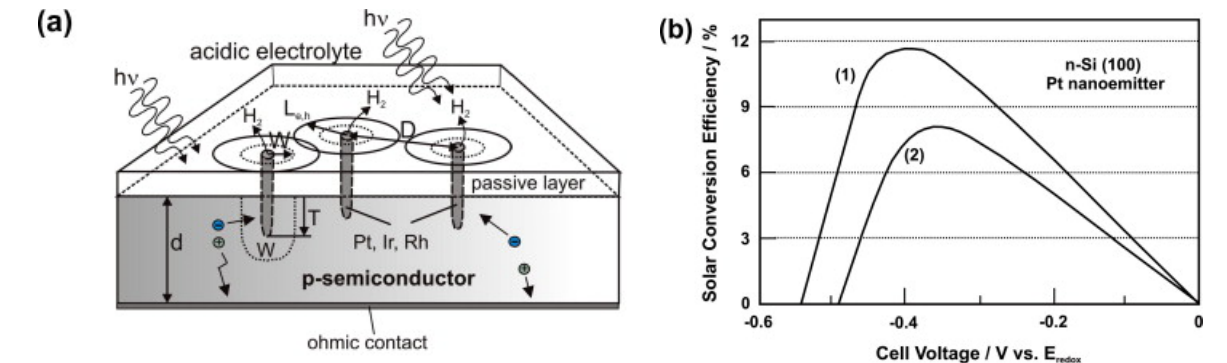
Figure 12. ( a ) Electrochemical solar cell design for protruding emitter noble metals in the electrolyte; ( b ) exemplary solar conversion efficiency at the redox electrolyte contact under an illumination of 100 mW cm − 2 after different pre-treatments: (1) after photocurrent oscillation in 0.1 M NH 4 F followed by electrochemical pore deepening in 1 M NaOH; and (2) after emersion at the decreasing branch of a photocurrent oscillation only. Reprinted from [300], with permission from Else- vier.